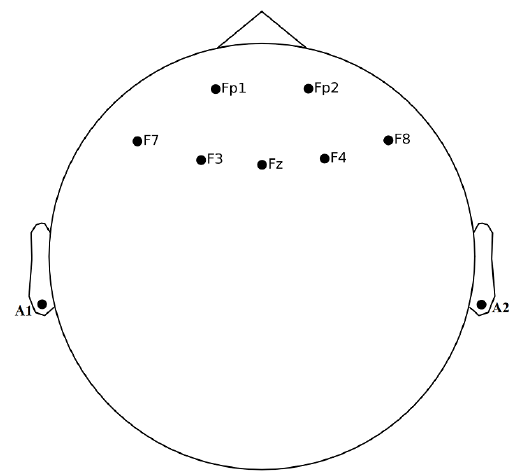
Figure 2. EEG Channels’ Position on